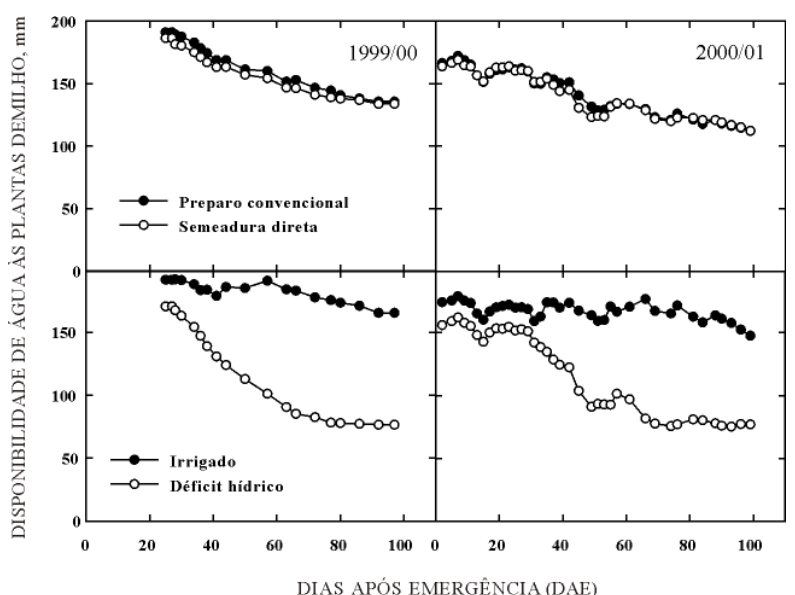
Figura 1. Disponibilidade de água às plantas de milho cultivadas em dois sistemas de manejo (semeadura direta e preparo convencional) e submetidas a dois manejos da água de irrigação (irrigado e déficit hídrico), durante os anos agrícolas 1999/00 e 2000/01. Santa Maria, RS, 2006.